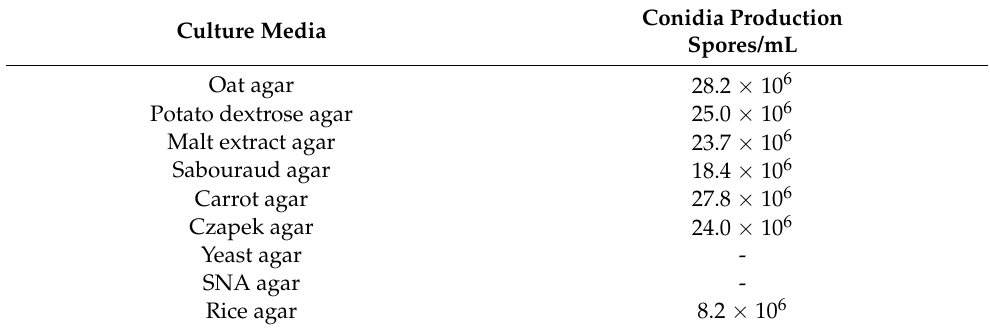
Table 2. Conidia production of C. virescens INIFAT C10/110 on different culture media after 10 days.